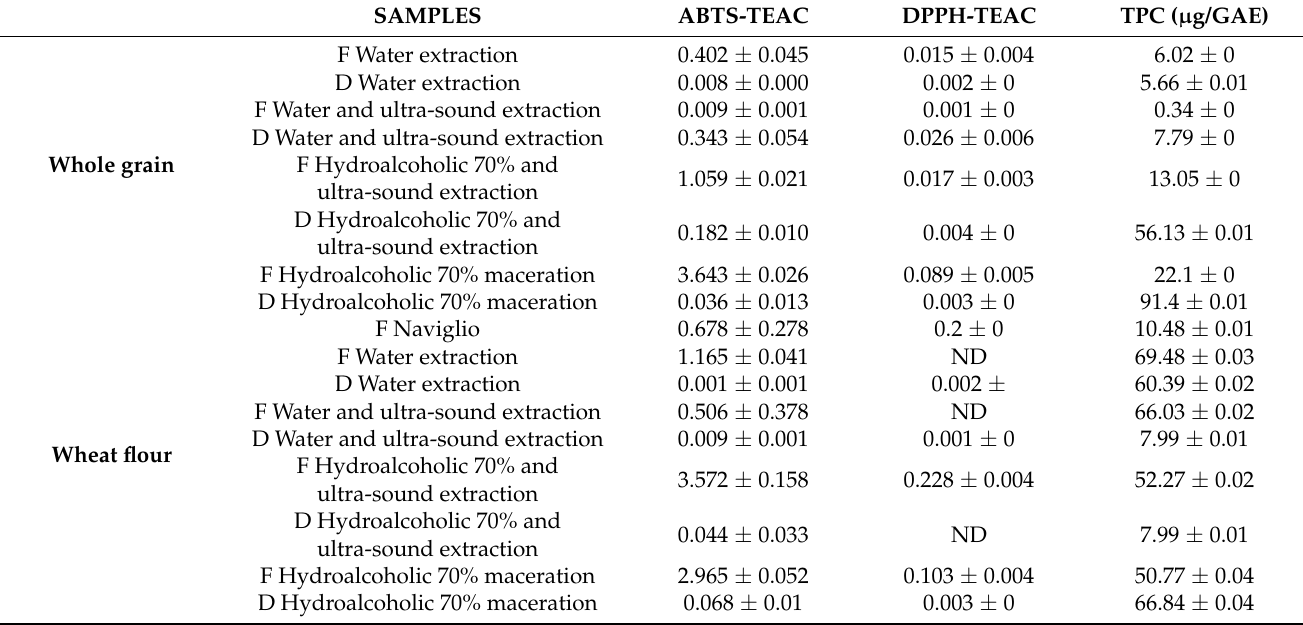
Table 4. Results of antioxidant activity in different wheat